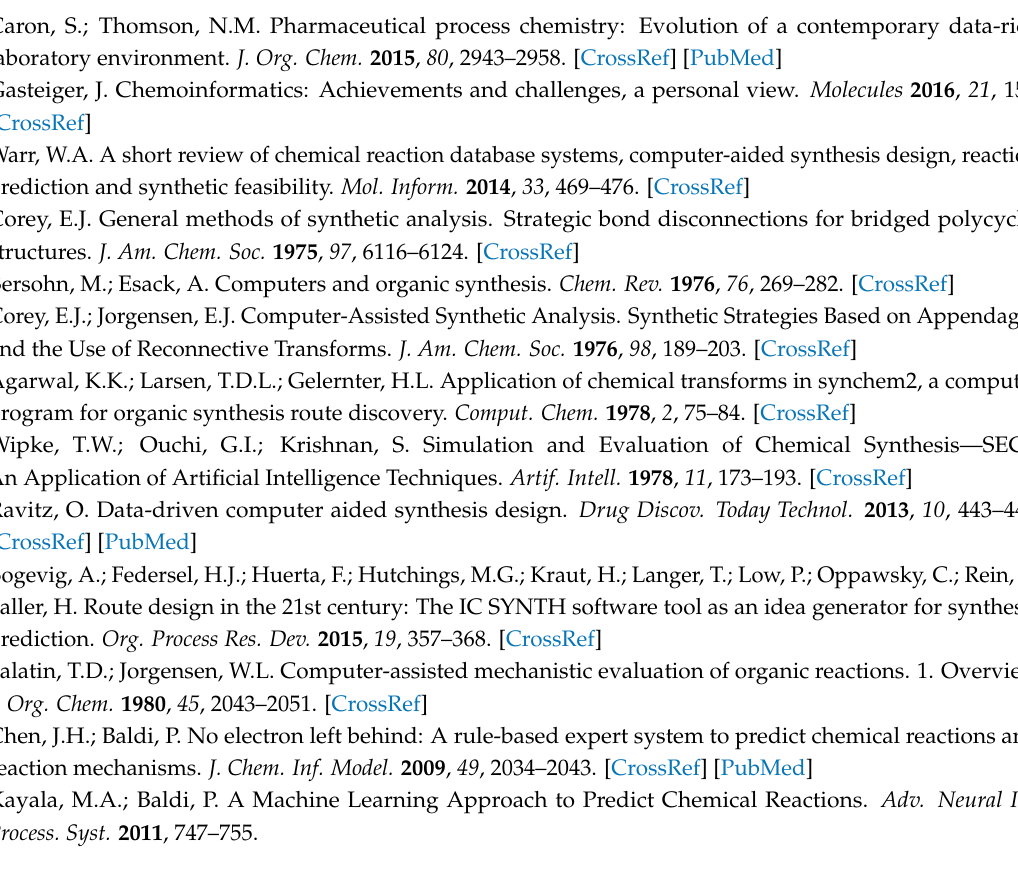
Supplementary Materials: Reaction data and reaction pathways for ibuprofen synthesis. The following